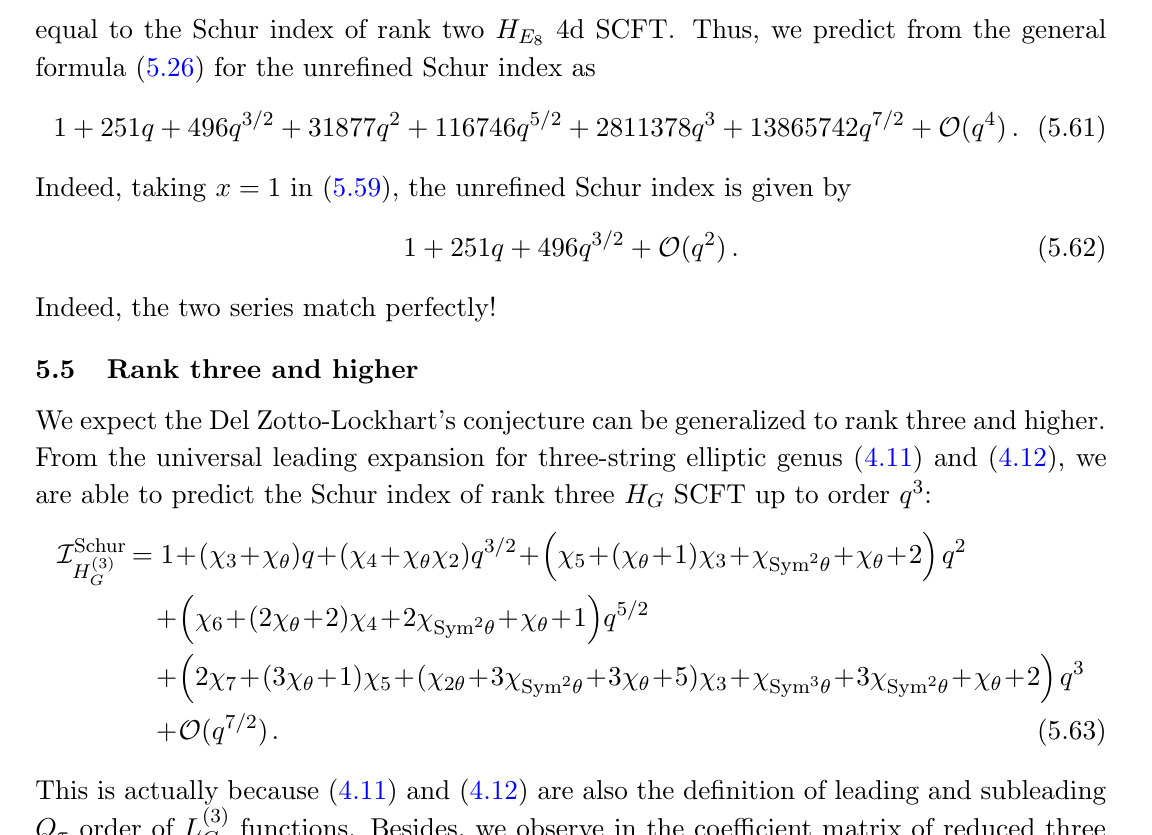
4d SCFT. Thus, we predict from the general E 8